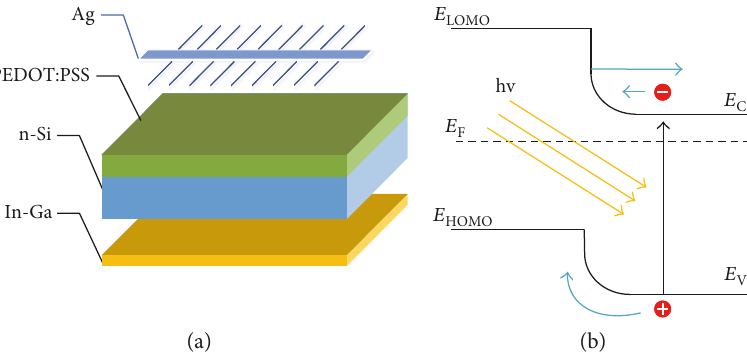
Figure 1: (a) Schematic structure of n-Si/PEDOT:PSS solar cell. (b) Schematic energy band diagrams of the